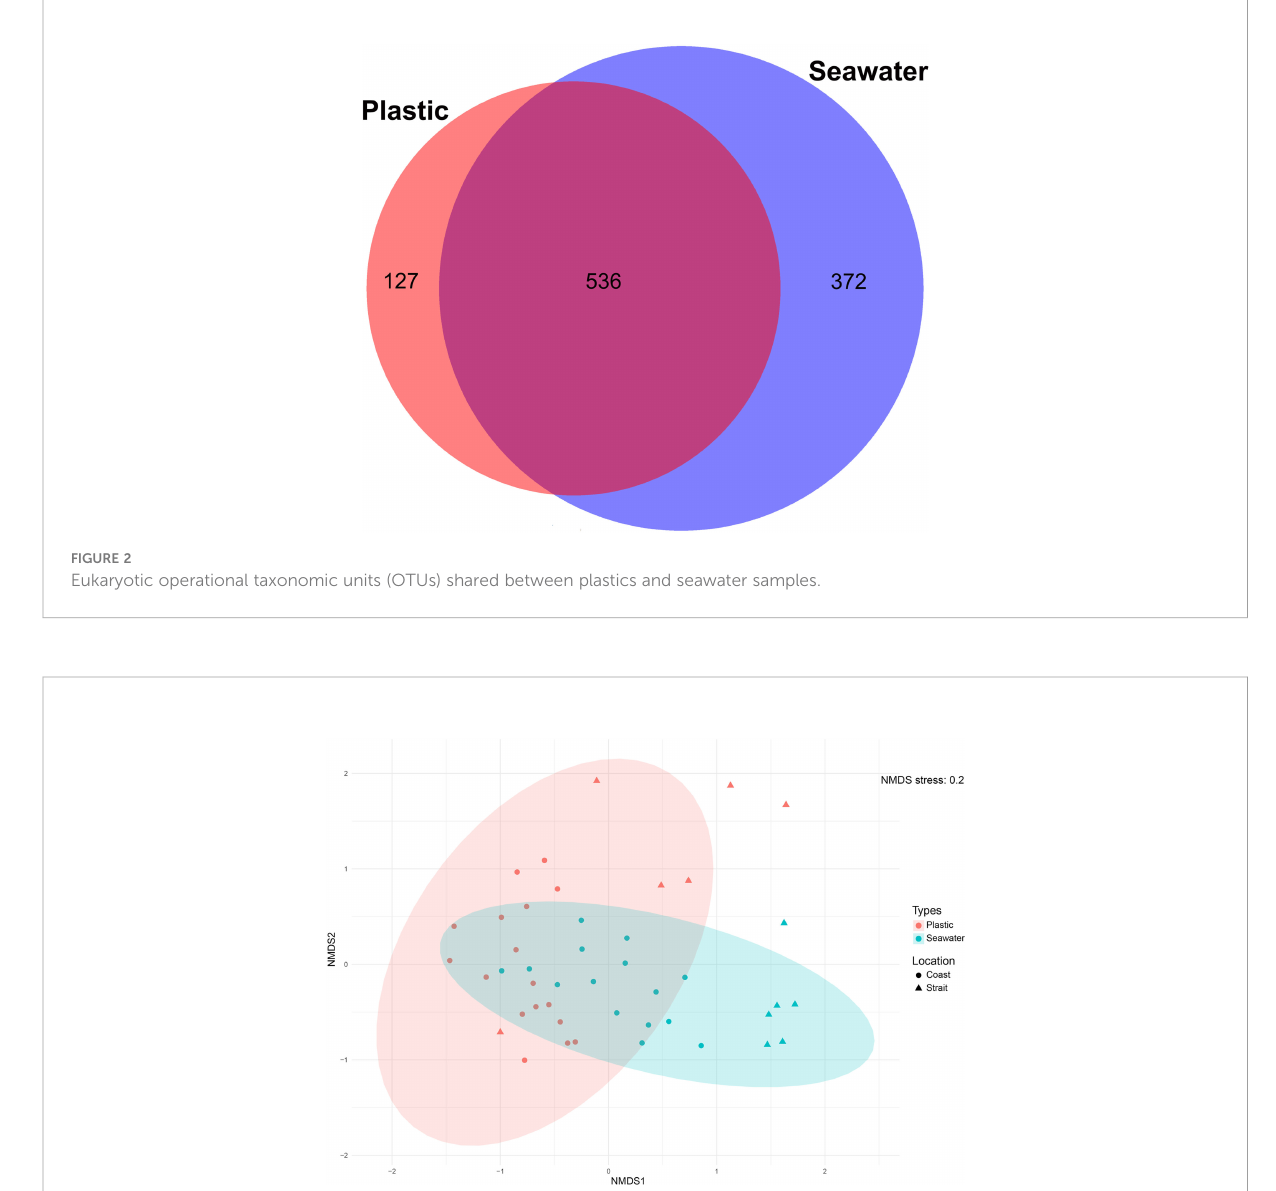
FIGURE 3 Non-metric multidimensional scaling (NMDS) ordination plots of Bray-Curtis dissimilarities for all samples across sample categories (i.e., sample types and sampling sites). Analysis was based on operational taxonomic units (OTUs) data